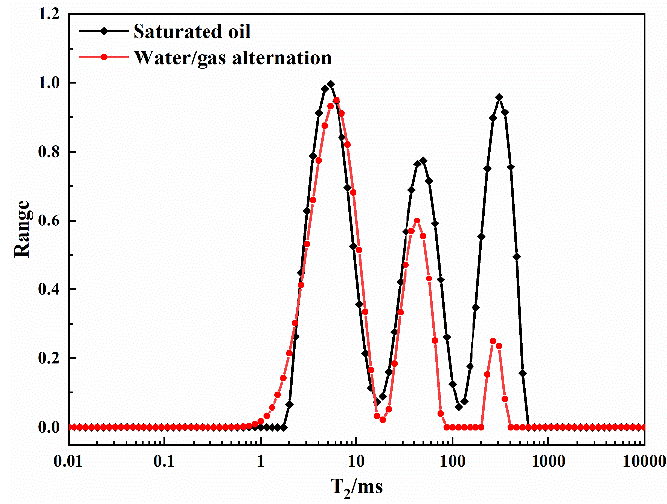
Figure 2. NMR T 2 spectrum of core 1 before and after water/gas alternation.